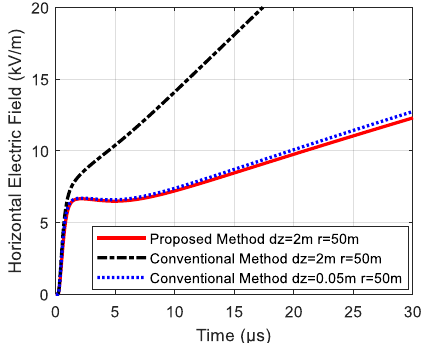
Figure 5. The horizontal electric field curves at the observation point calculated by the proposed method and the conventional method under different dz ’.